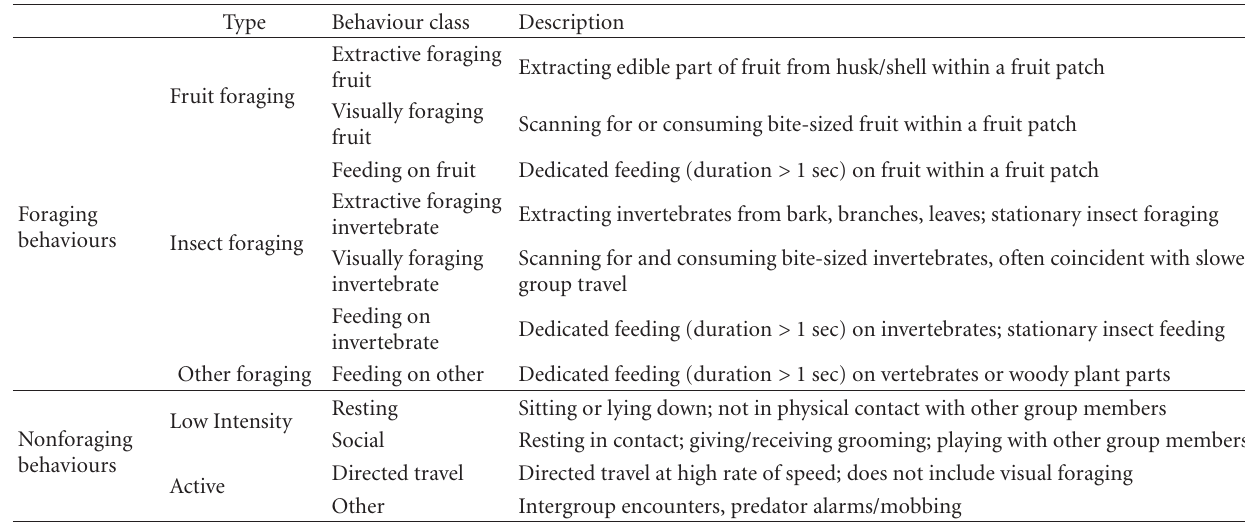
Table 2: Ethogram of the behaviour classes recorded during behavioural scan samples of Cebus capucinus in Sector Santa Rosa, ACG, Costa Rica.